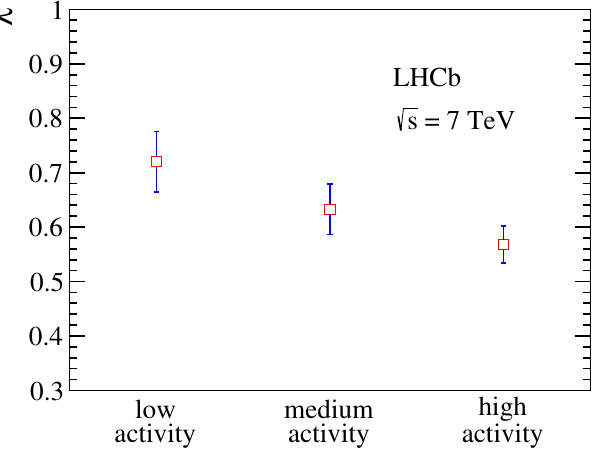
Figure 4 . Chaoticity parameter (cid:21) as a function of activity. Error bars indicate the sum in quadrature of the statistical and systematic uncertainties. The points are placed at the centres of the activity